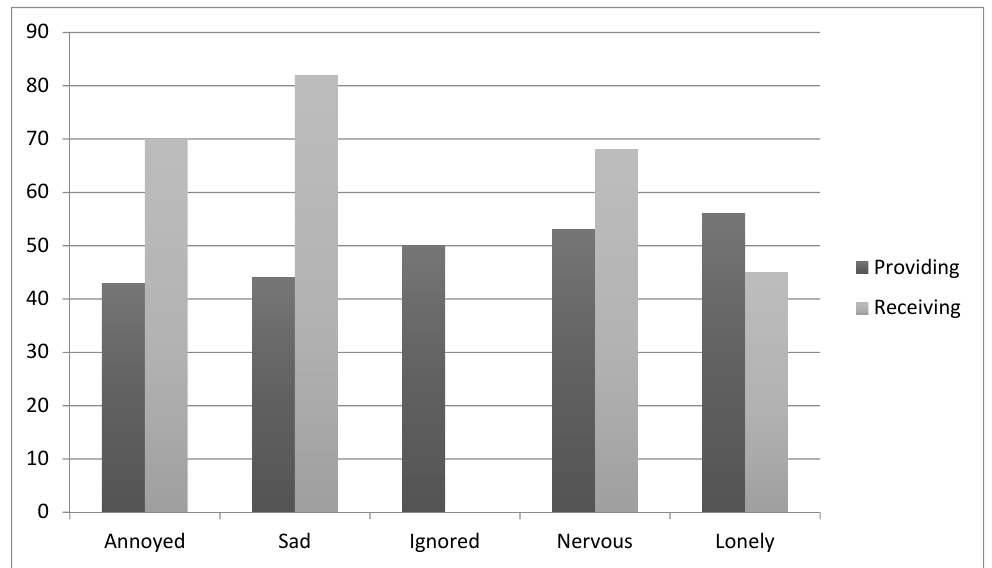
Figure 3. Emotional attributes associated with providing versus receiving poor customer service (Y-axis shows the percentage of people significantly associating primes with the receipt and provision of poor service).